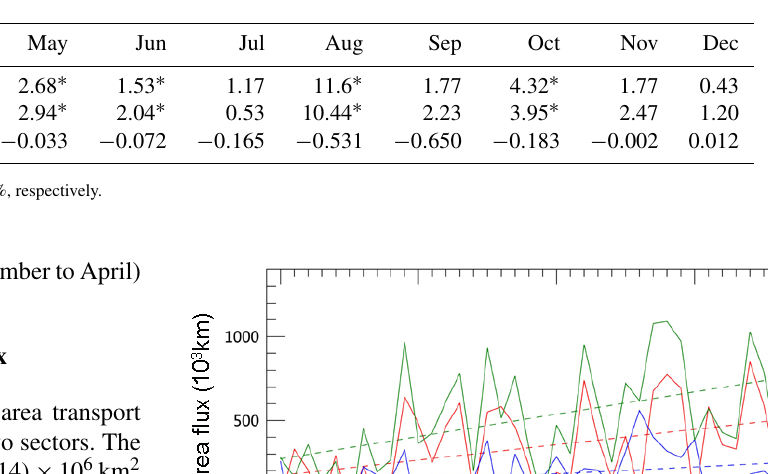
Figure 5. Sea ice motion trend in (a) January and (b) August. The magnitude of ice motion is indicated by background color and the length of arrows. Table 2. Monthly trends for the sea ice area flux between PA and AA. The trends for the SIM and SIC fields over the fluxgate are also provided (%yr − 1 ).